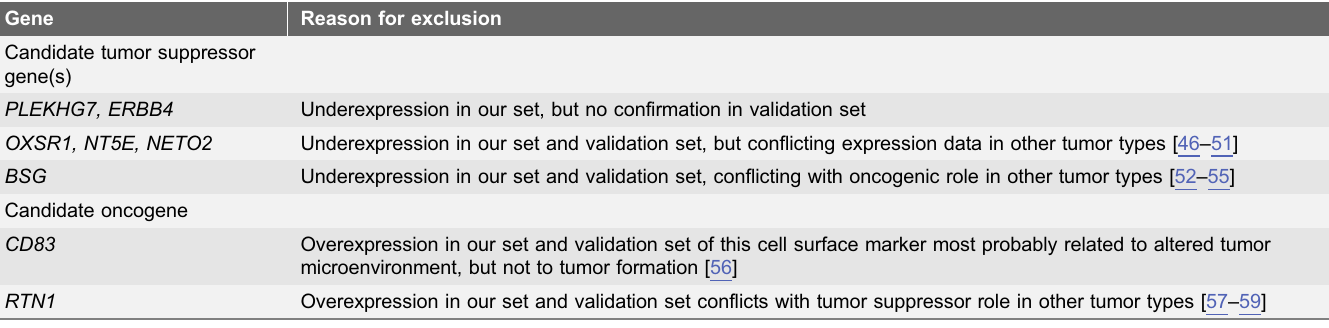
Table 4. Excluded newly identified driver